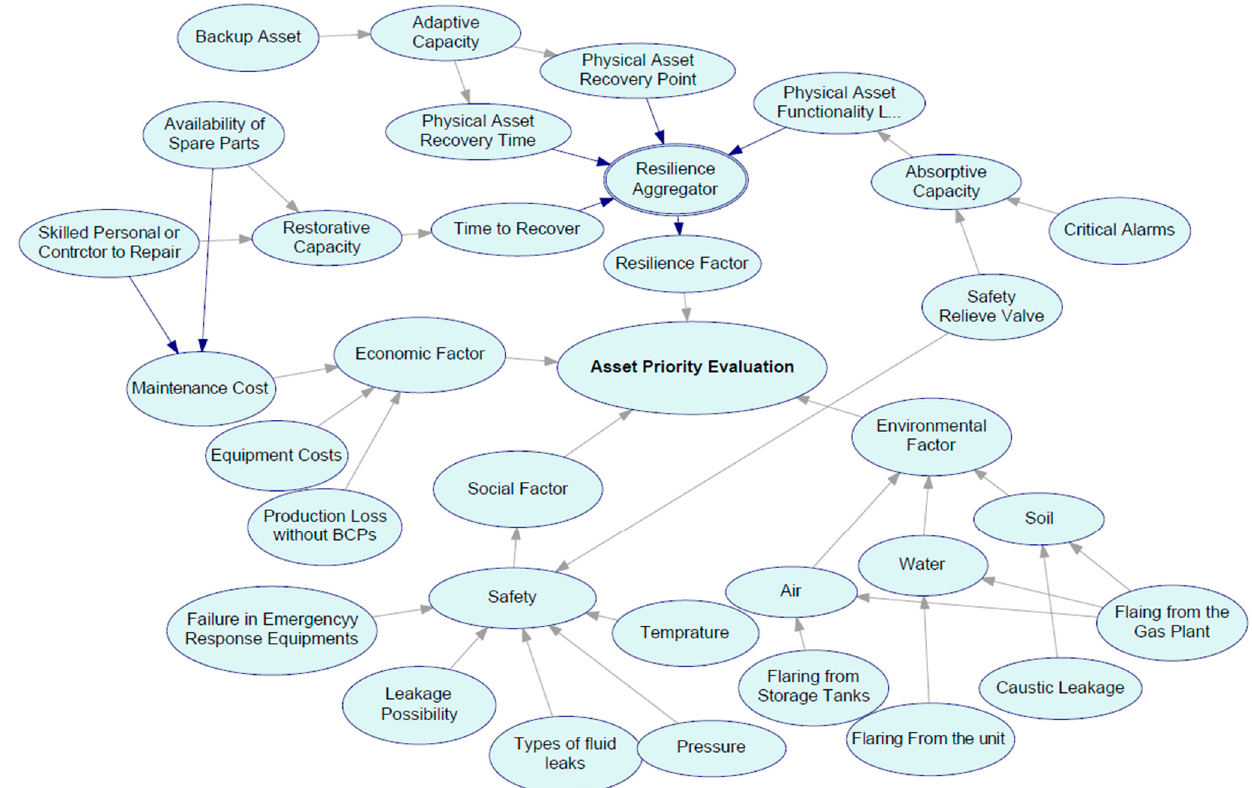
Figure 4. Bayesian network structure for GP’s physical asset criticality analysis.